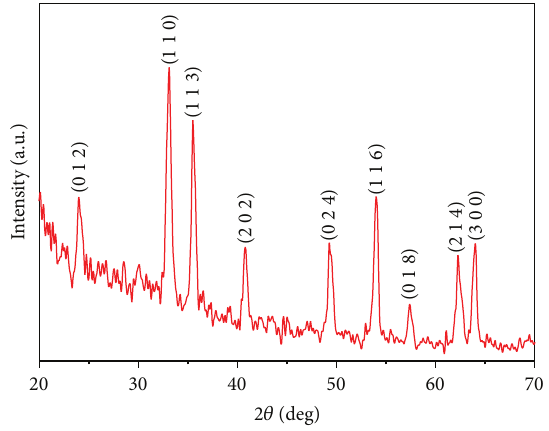
Figure 2: X-ray diffraction pattern observed for as-prepared 𝛼 - Fe 2 O 3